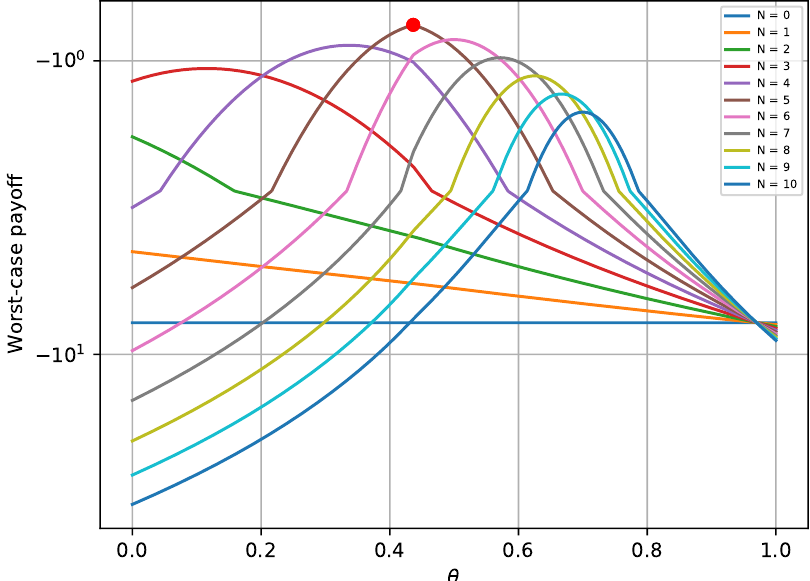
Figure 4. Defender’s worst-case payoff when equilibrium does not